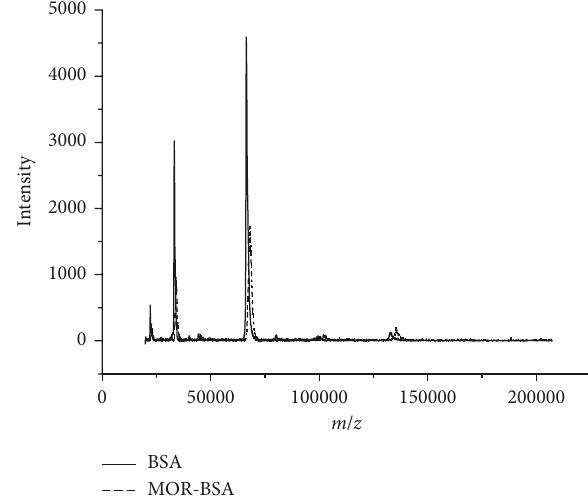
Figure 4: Spectrogram of MOR hapten by MALDI-TOF-MS method.